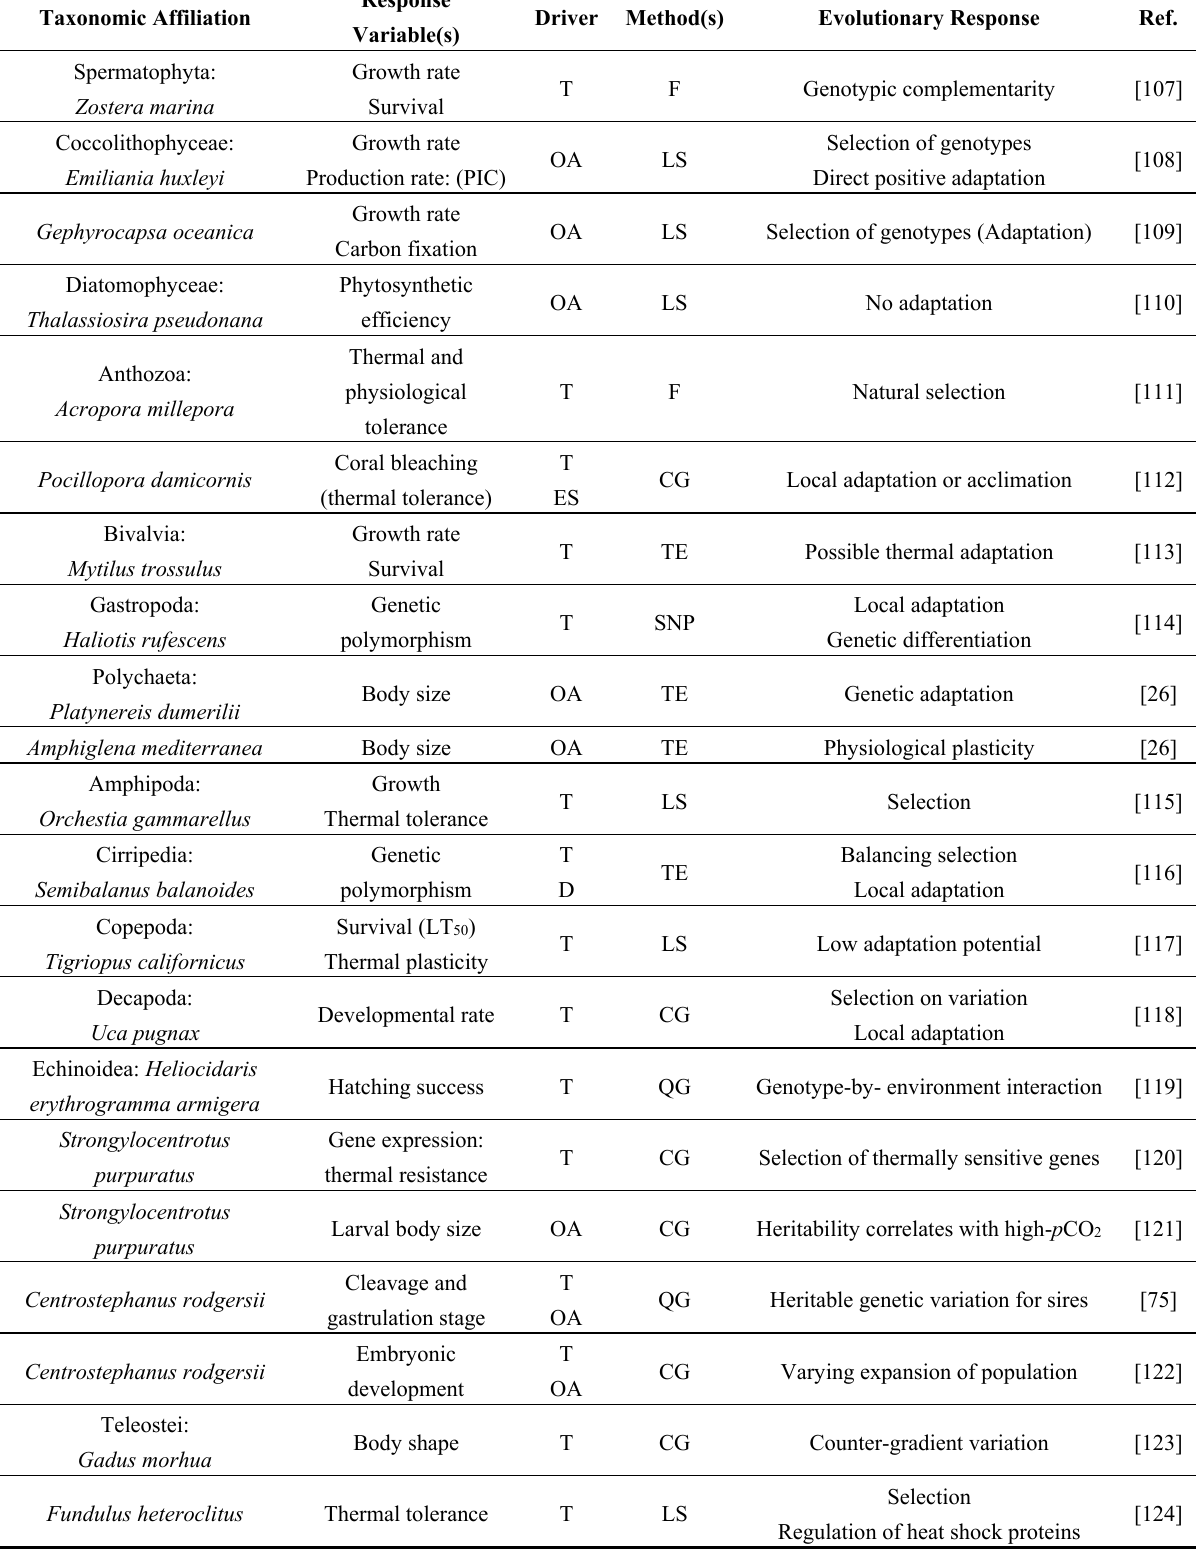
Table 1. Published studies investigating population level evolutionary responses to climate change (including ocean acidification) in marine